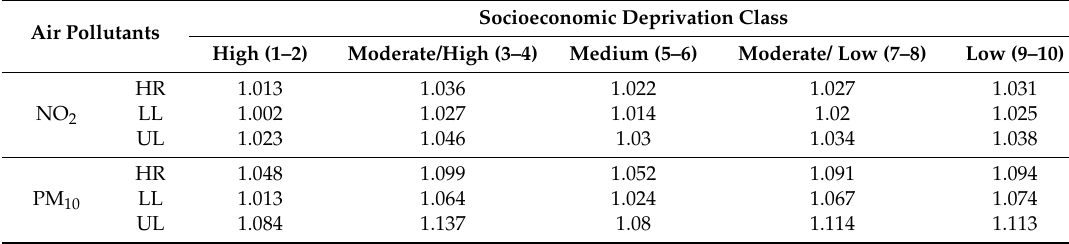
Table 3. Associations between long-term NO 2 and PM 10 exposure and mortality all-causes by socioeconomic class extracted from the Dutch study [14].